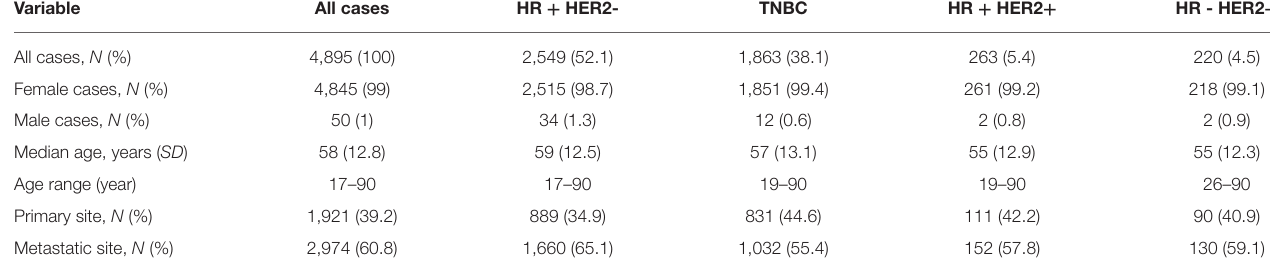
TABLE 1 | Patient and tumor characteristics.